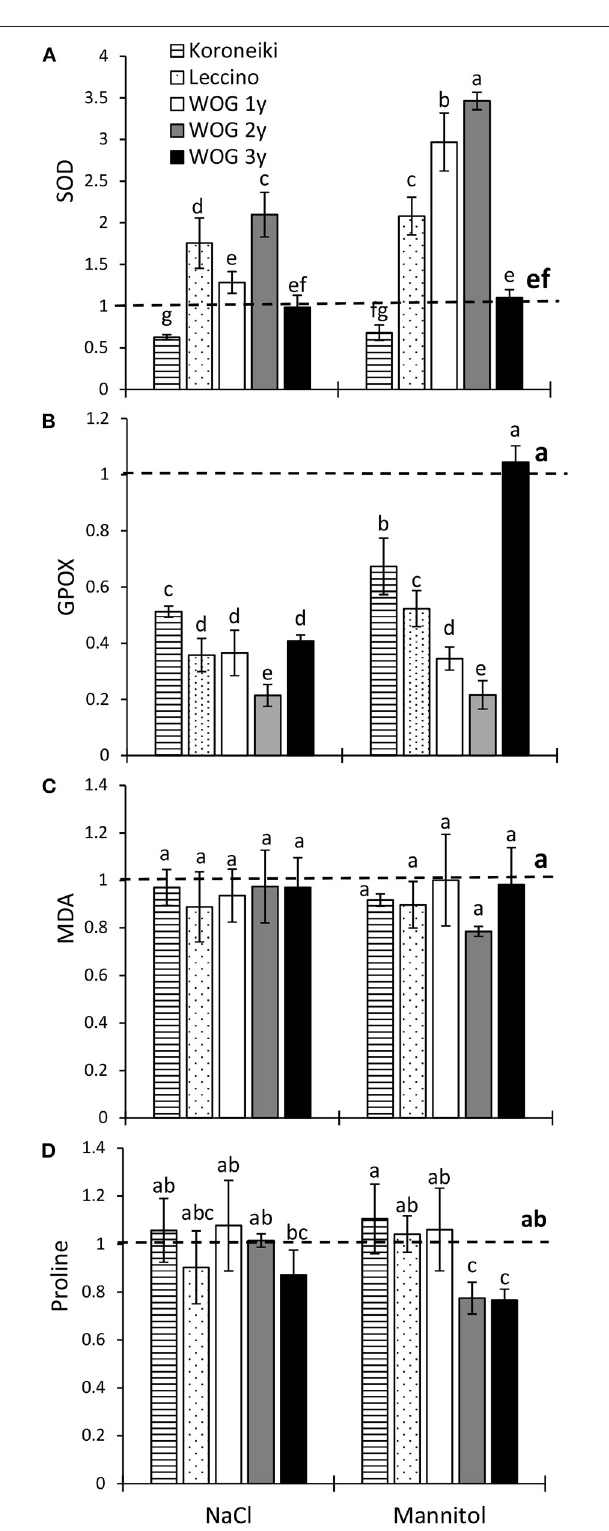
FIGURE 3 | The relative activity of superoxide dismutase (SOD) (A) and guaiacol peroxidase (GPOX) (B) , relative contents of malondialdehyde